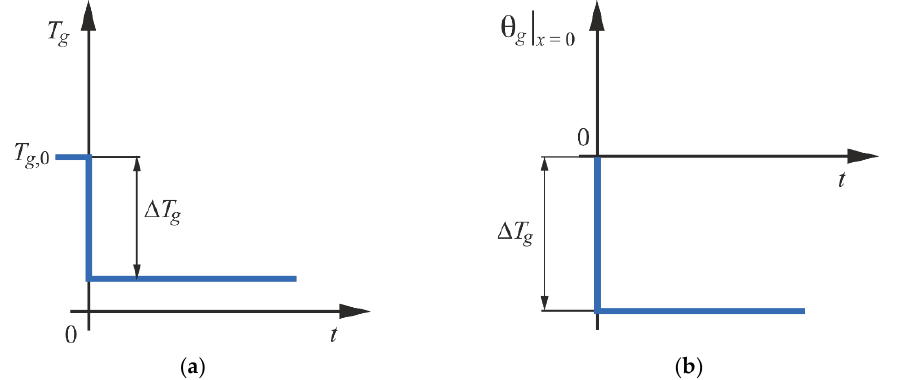
Figure 6. Changes in air temperature at the accumulator inlet: ( a ) air temperature changes T g ; ( b ) changes in temperature difference θ g